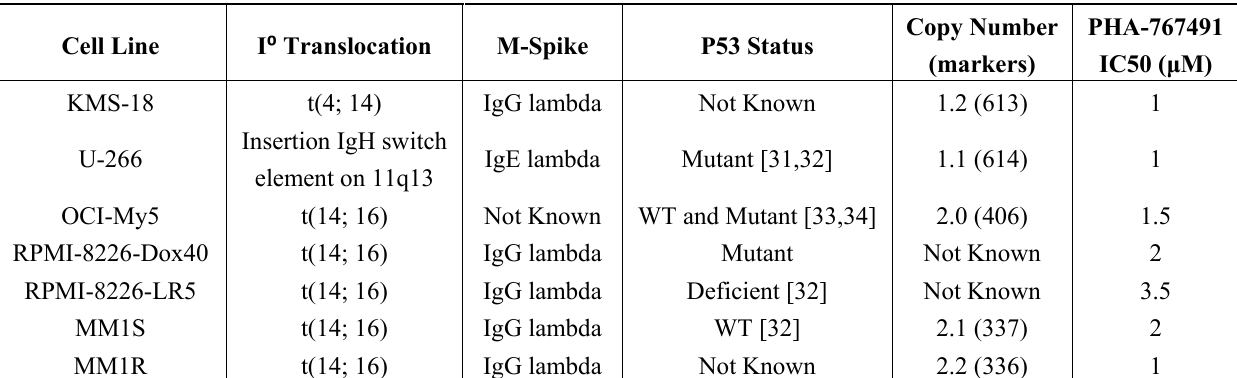
Table 1. Anti-proliferate activity of PHA-767491 in multiple myeloma cell lines with diverse genetic and molecular features. The indicated established myeloma cell lines were treated with increasing amount of PHA-767491. Cell viability was examined by CellTiter Glo 48 h after drug treatment. The IC was calculated using GraphPad 50